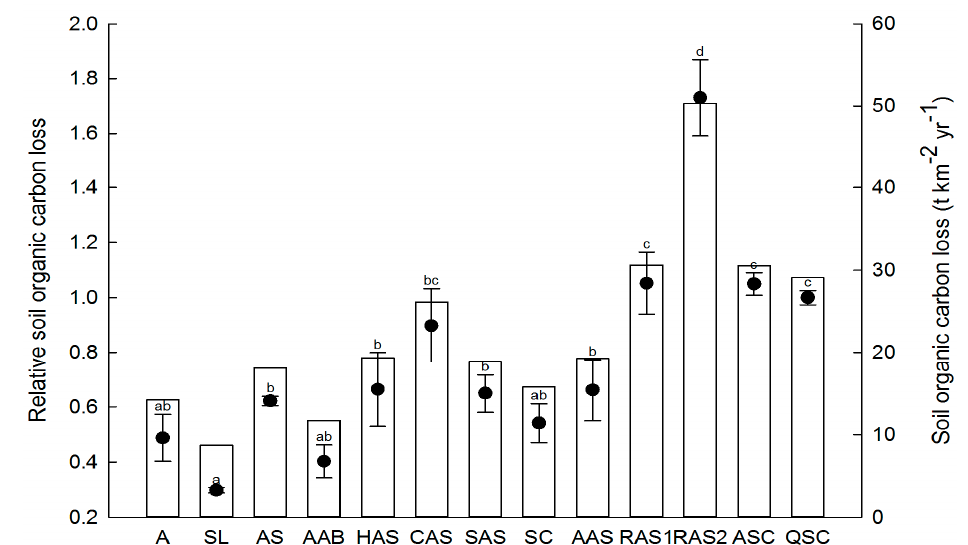
Figure 3. Soil organic carbon loss and relative soil organic carbon loss in different plant communities under extreme rainstorm events during 2013. Vertical columns and black circles represent soil organic carbon loss and relative soil organic carbon loss, respectively. Different lowercase letters indicate significance at p < 0.05 for relative soil organic carbon loss between different plant communities. A: Artemisia scoparia (3–5 years); SL: S. bungeana + L. davurica (10–20 years); AS: